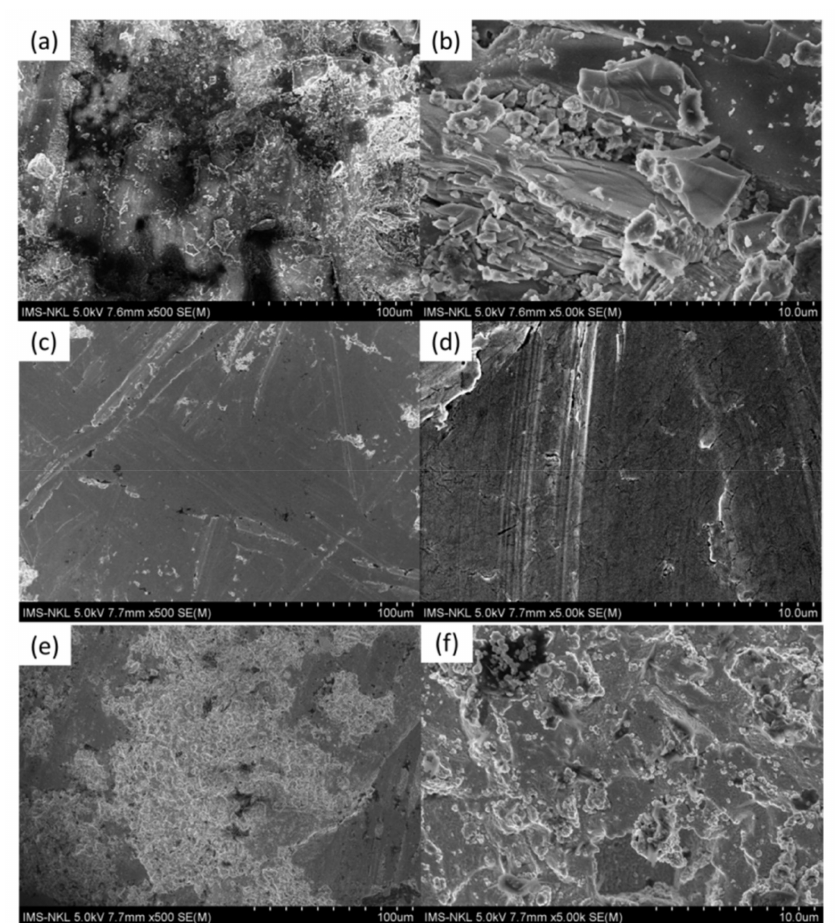
Figure 1. SEM images of ( a , b ) bare AH36, ( c , d ) cleaned AH36, and ( e , f ) Cu@AH36 at different